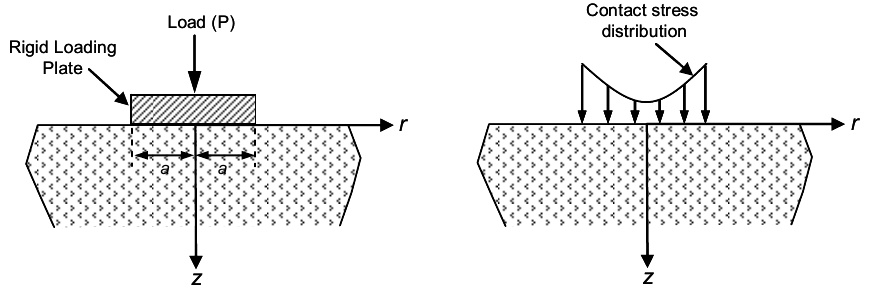
Figure 13. Free diagram of a rigid loading plate problem.